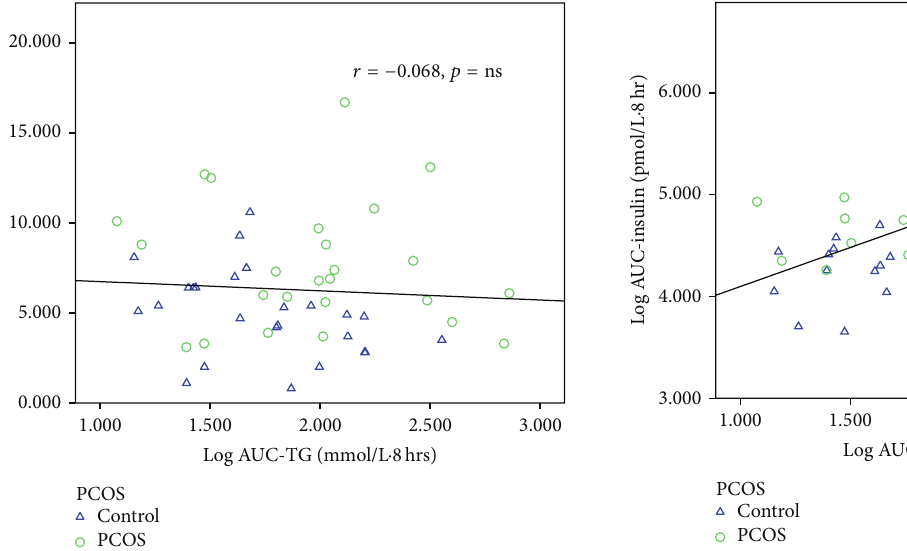
Figure 8: Correlation between AUC-TG and DHEAS. Figure 9: Correlation between AUC-TG and